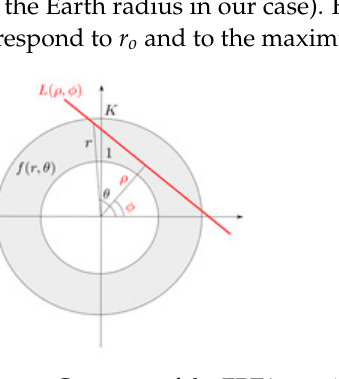
Figure 2. Geometry of the ERTA acquisition system.